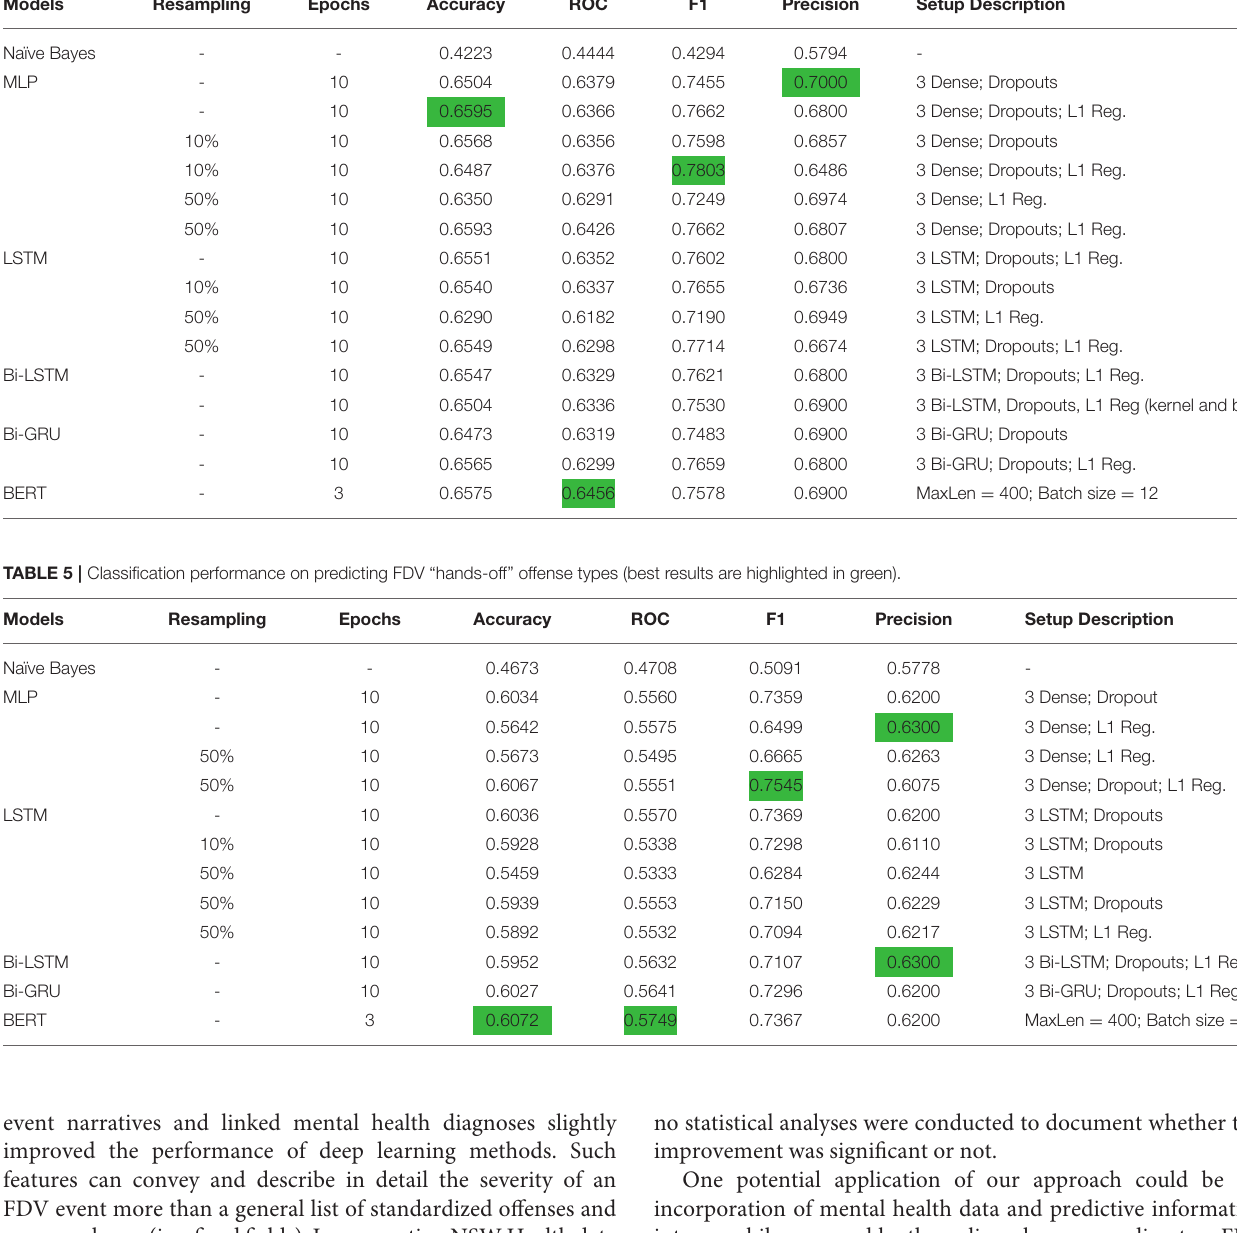
TABLE 4 | Classification performance on predicting “hands-on” FDV offense types (best results are highlighted in green). Models Naïve Bayes